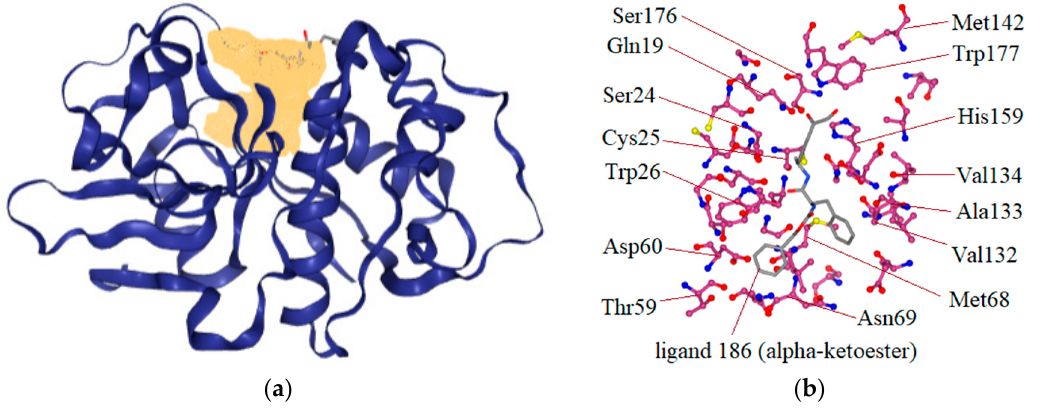
Figure 2. Binding site detection of the binding site on the crystallographic structure 1U9Q. This pocket, yellow region ( a ) was detected by DoGSiteScorer tool using ProteinsPlus server. ( b ) Interactions recorded in cruzain-ligand 186 complex.